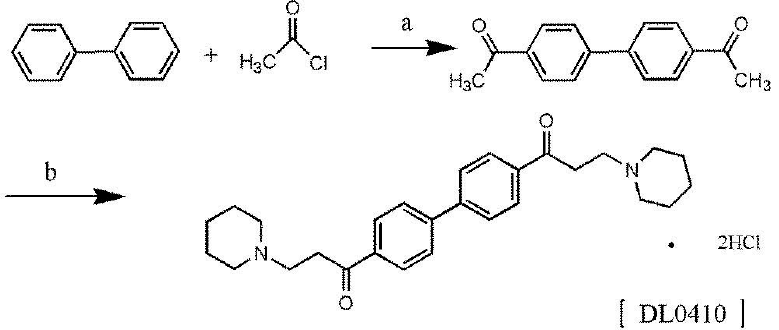
Figure 1. The synthetic route of DL0410. Reagents conditions and yields: (a) CS 2 , AlCl 3 , reflux 4 h, 90%; (b) piperidine hydrochloride, 36–38% HCHO, acetic anhydride, 51.5%.